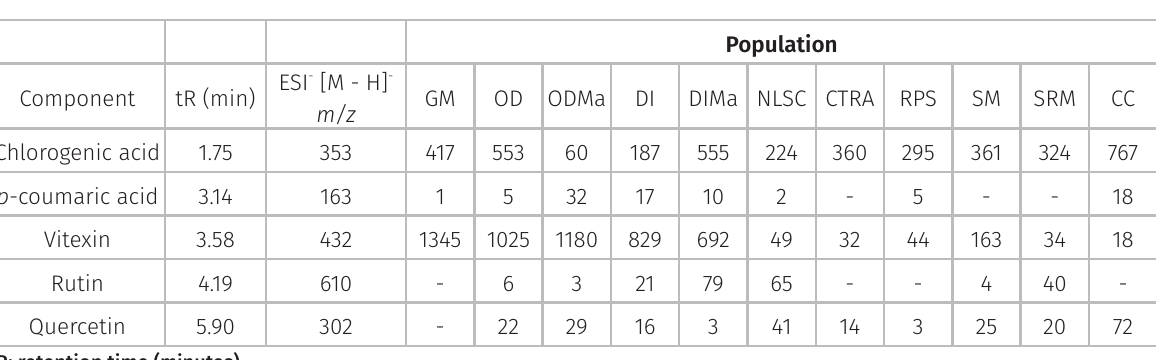
Table III. Phenolic constituents (ng/g) identified in leaves of populations of Lychnophora pinaster , State of Minas Gerais,